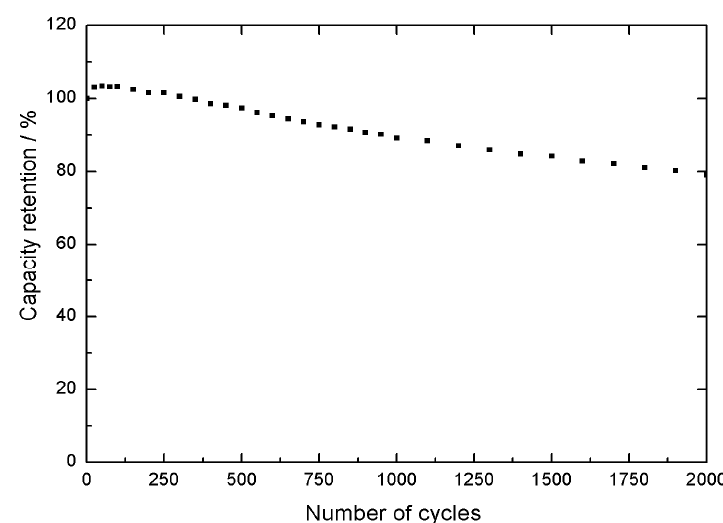
Figure 6. Capacity retention with continuous cycling of the positive electrode material at 100 mA cm − 2 in the − 0.3 V to 0.5 V vs. SCE voltage interval.